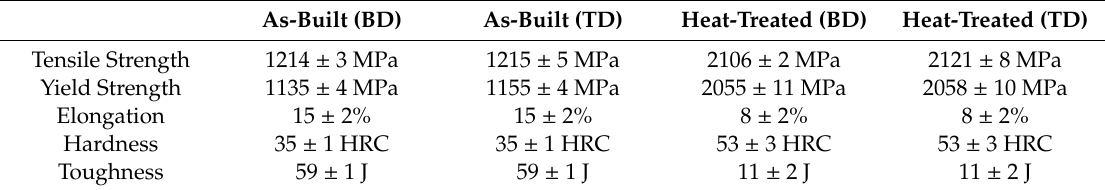
Figure 10. ( a ) The stress-strain curves of the as-printed and heat-treated samples. ( b ) A magnified view of the stress-strain curves in Figure 10a. Table 2. Mechanical properties of X3NiCoMoTi18-9-5 maraging